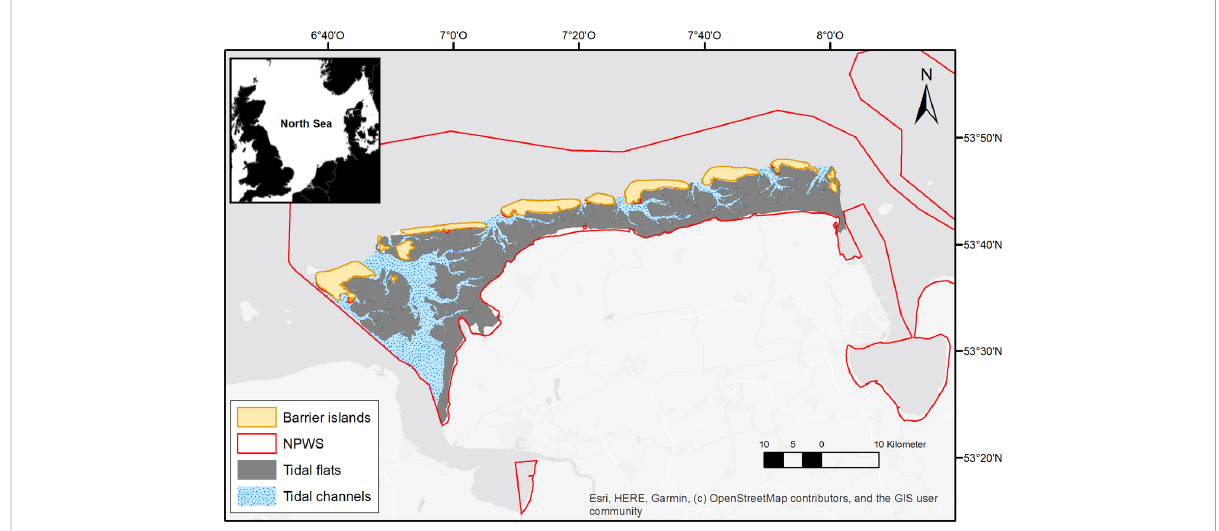
FIGURE 1 Study area in the East-Frisian Wadden Sea (EFWS), showing the tidal fl ats, the tidal channels, the 7 large East-Frisian barrier islands and the border of the Wadden Sea National Park (NPWS) in the Lower Saxony region, shape fi les provided by the Lower Saxony Wadden Sea National Park Authority